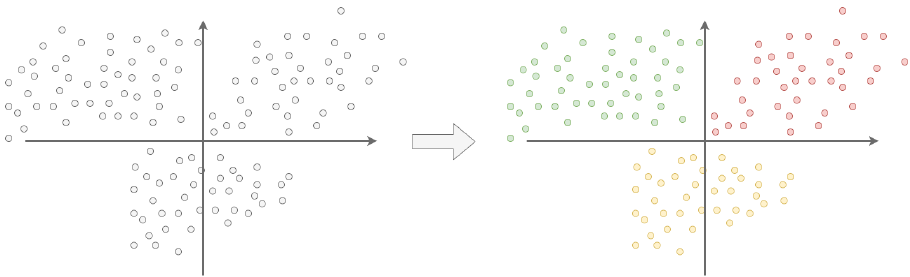
Figure 9. Representation of a simple clustering